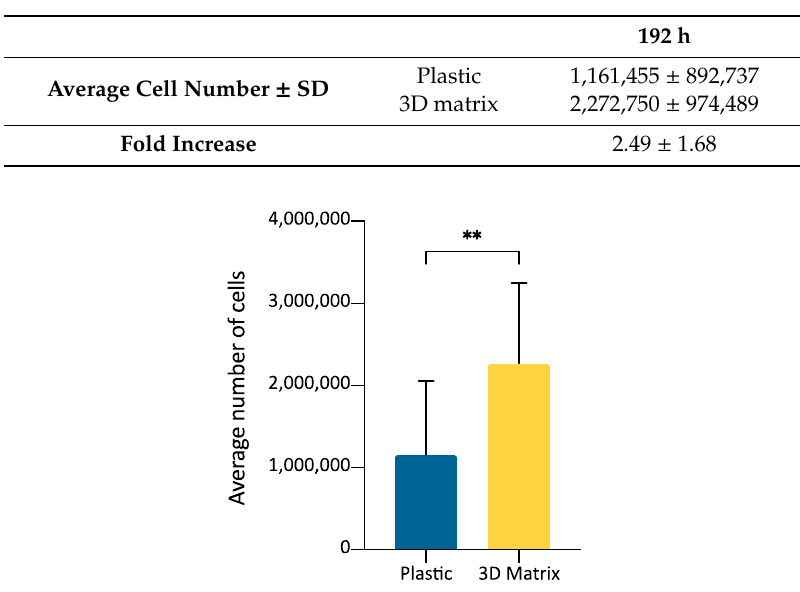
Figure 6. Graph bars representing the average number of cells obtained from adipose tissue derived SVF cells expanded on plastic surface or inside a 3D matrix prepared from PPP ( n = 3). Statistically significant differences are indicated as follows: ** p ≤ 0.01.